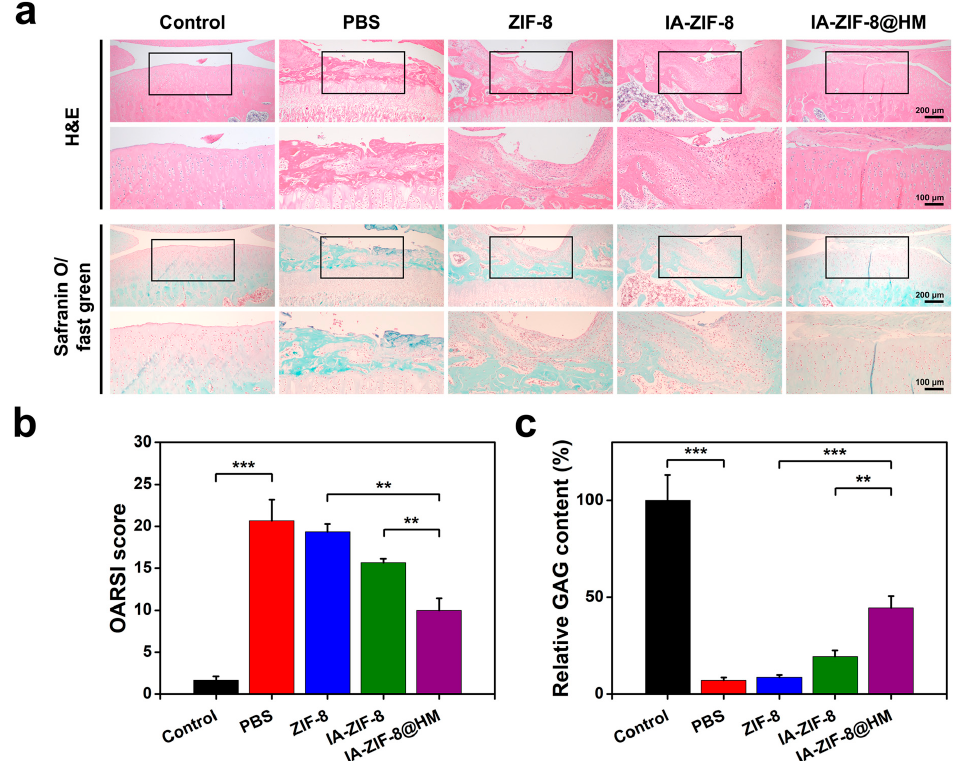
Figure 5. IA-ZIF-8@HM relieved the progression of OA in vivo experiments. ( a ) Histopathological images of each group after the treatment. ( b ) OARSI scores of articular cartilage for different groups after the treatment (** p < 0.01, *** p < 0.001). ( c ) Relative glycosaminoglycan (GAG) content for different groups after the treatment (** p < 0.01, *** p < 0.001).